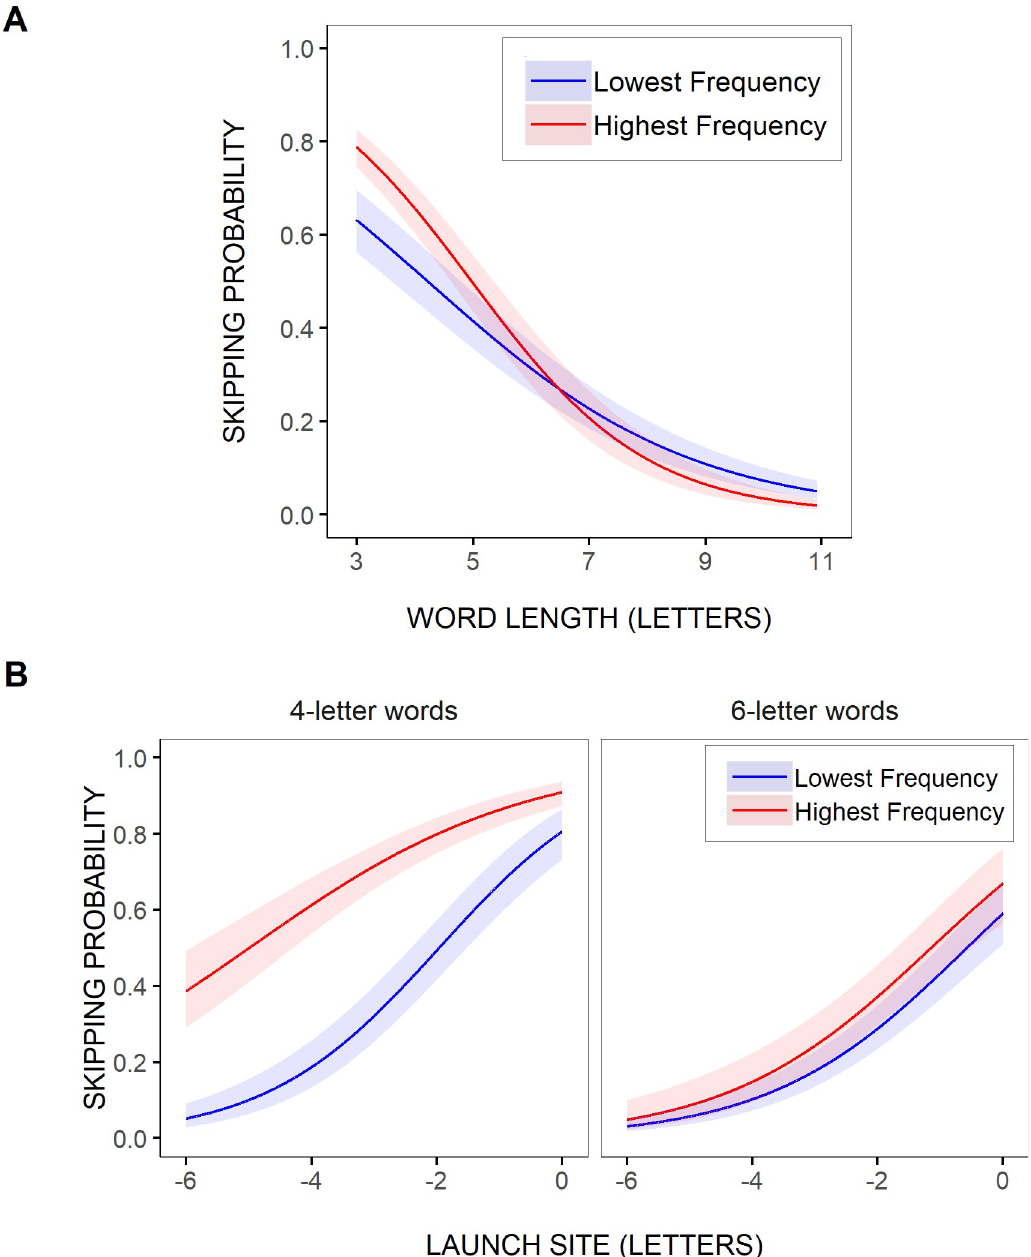
Fig 6. Estimated effect of visuo-motor and linguistic variables on word-skipping rate. Partial effects (with 95% confidence intervals) computed from the parameters of GLMM Model 1’ (A; Table 4) and GLMM Model 2’ (B; Table 5), representing the probability of word skipping across all words in the sentences as a function of word length (A) and for 4- and 6-letter words as a function of saccadic launch-site distance (in letters relative to the space in front of the words; B), separately for the two most extreme (i.e., the lowest vs. the highest) word-frequency values across all words selected for analysis (0.01 and 9.59 log units respectively). short 4-letter words, that held over the entire range of tested saccadic launch-site distances ( > = -6 letters), but barely no frequency effect in longer, 6-letter, words, except maybe for very-small launch-site distances. This effect, even in 4-letter words where it was the largest,